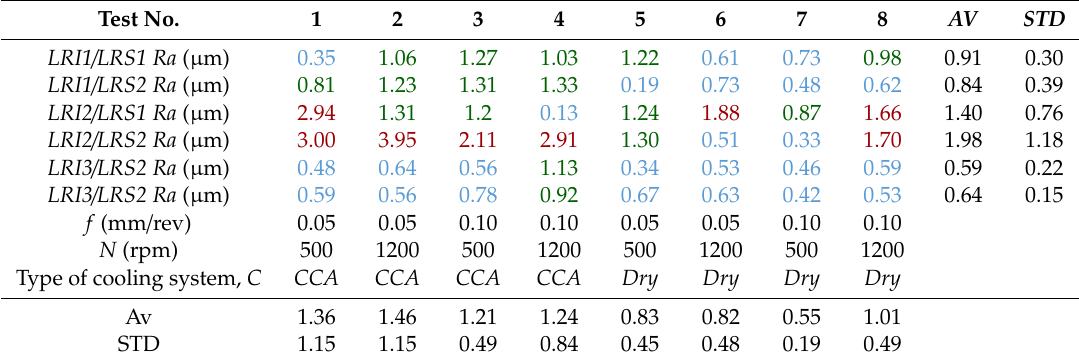
Table 4. Mg-Al-Mg test. Arithmetical Mean Roughness, Ra ( µ m) in each plate at the entry and at the exit zones of the holes.